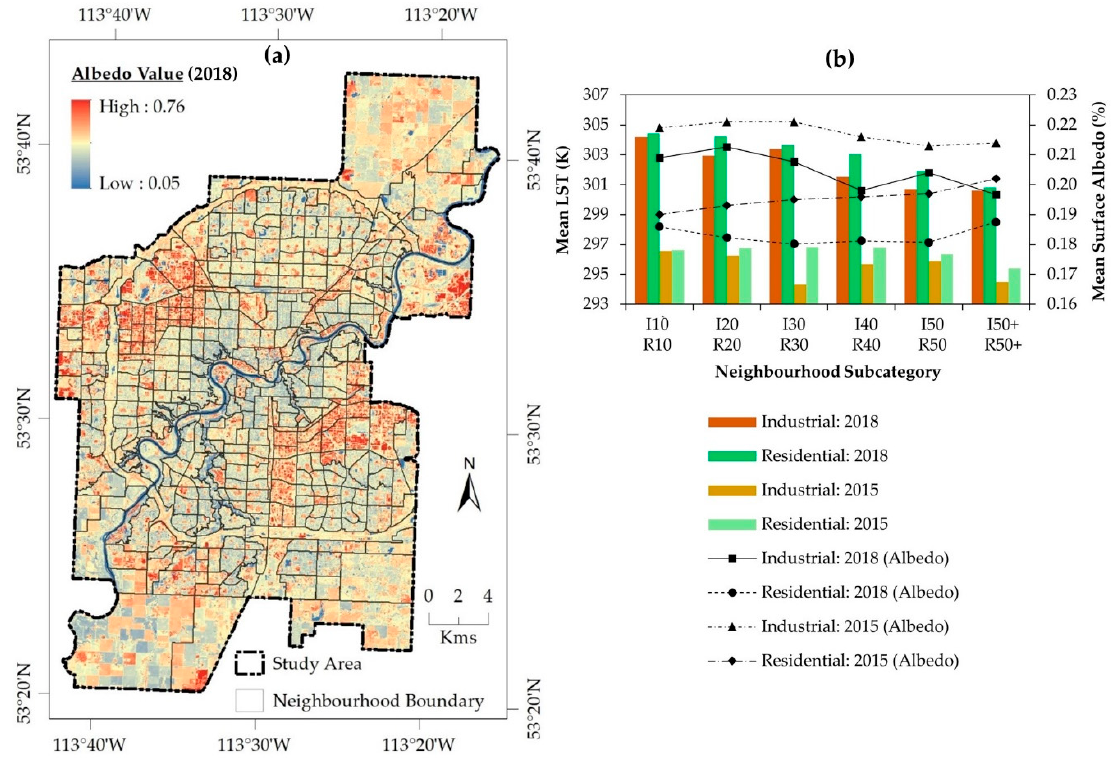
Figure 6. ( a ) Map showing the estimated values of surface albedo (2018), where the red to reddish colour tones represent the higher albedo values in compared to the lower albedo values represented by the blue to bluish. The yellow to yellowish colours represent the medium level of albedo; ( b ) surface albedo of subcategorized industrial neighbourhoods indicated high surface albedo (both 2018 and 2015), while low surface albedo for residential subcategories (both 2018 and 2015).